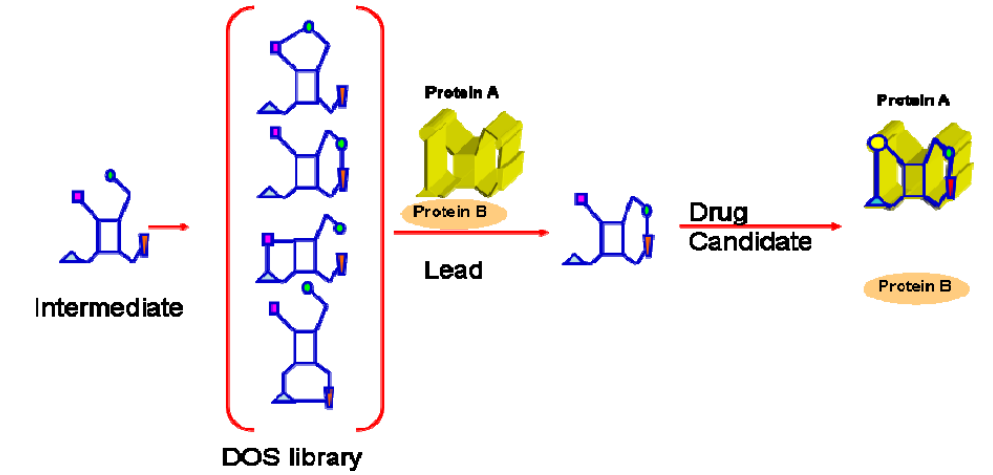
Figure 1. In DOS, libraries of structurally diverse compounds are derived from common intermediates (reaction of the same starting material with different reagents or reaction of different starting materials with common reagents). Different chemical groups are presented with different colors. The binding cavity that is targeted by DOS compounds in a protein-protein interaction is colored in yellow. Optimized DOS compounds can dissociate such